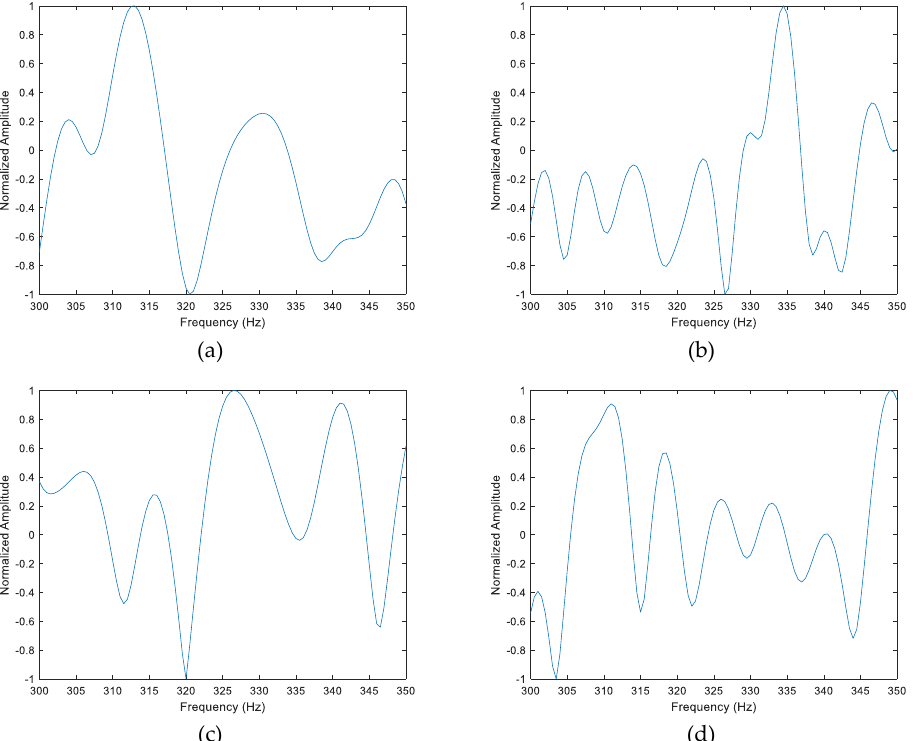
Figure 5. The features of four samples of the simulation data, where the horizontal axis represents the frequency from 300 to 350 Hz and the vertical axis represents the normalized amplitude from − 1 to 1: ( a ) the 1st features of the surface source; ( b ) the 930th features of the surface source; ( c ) the 931st features of the underwater source; ( d ) the 2790th features of the underwater source.